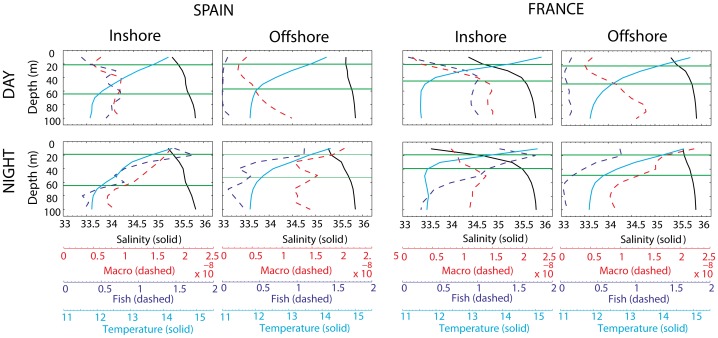
Overall day-night vertical profiles of physical and biological variables.Temperature (light blue solid line), salinity (black solid line), macrozooplankton biomass (red dashed line), and fish biomass (dark blue dashed line) vertical distributions are represented in inshore and offshore domains in the Spanish and French areas. The upper and lower thermocline are represented as green horizontal lines.